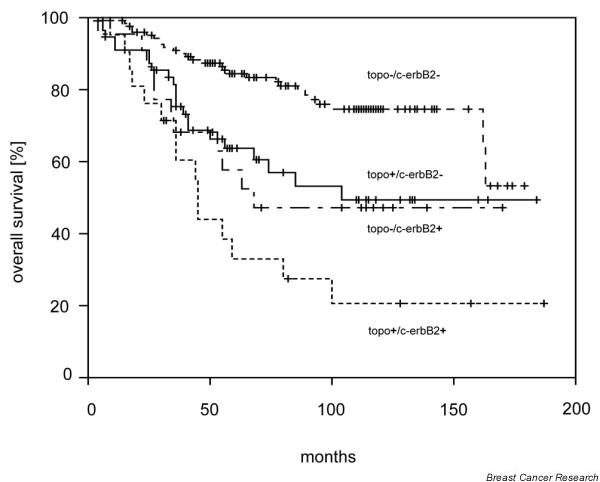
Survival of patients with and without overexpression of c-erbB2 and topoisomerase IIα. The difference between patients without overexpression of c-erbB2 or topoisomerase (broken line), patients with tumors overexpressing one of the two proteins (c-erbB2, dot–dashed line; topoisomerase IIα, solid line), and patients with tumors overexpressing both c-erbB2 and topoisomerase IIα (dotted line) was significant (log rank 29.71; P < 0.0001).